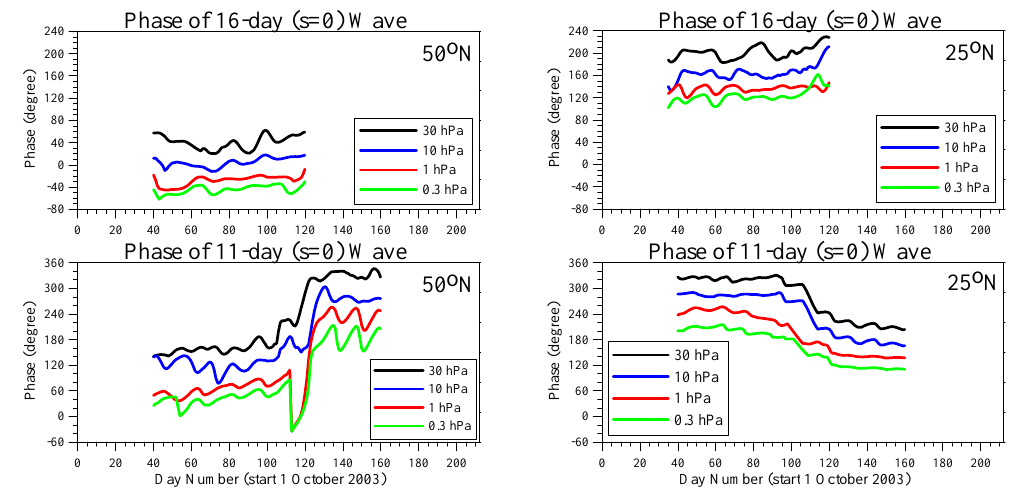
Figure 4 Fig. 4. Phases of the ∼ 16- (upper row of plots) and ∼ 11-day (bottom row of plots) zonally symmetric waves at 50 ◦ N (left column of plots) and 25 ◦ N (right column of plots); the phases are presented at studied four pressure levels.